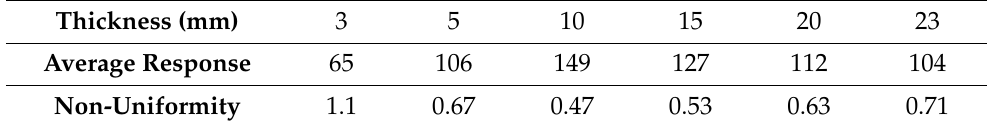
Figure 11. Response uniformity of different thicknesses of scintillating glass tile. Transverse size is fixed with 30 × 30 mm 2 : ( a ) 30 × 30 × 3 mm 3 ; ( b ) 30 × 30 × 5 mm 3 ; ( c ) 30 × 30 × 10 mm 3 ; ( d ) 30 × 30 × 15 mm 3 ; ( e ) 30 × 30 × 20 mm 3 ; ( f ) 30 × 30 × 25 mm 3 . Table 2. Average response and non-uniformity with different